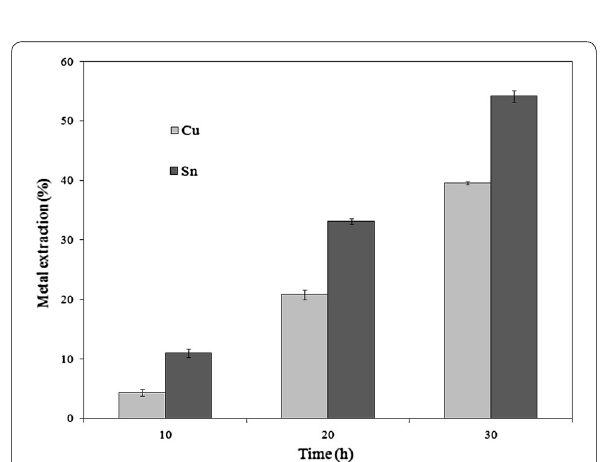
Fig. 7 Effect of microbially produced acetic acid on metal recovery from Sn–Cu solder (100 mg) at 150 rpm shaking speed and 30 h